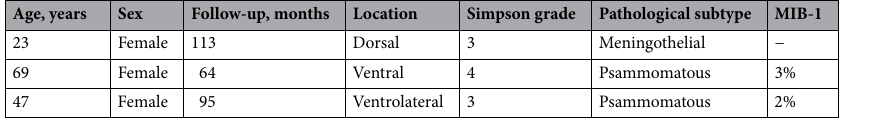
Table 3. Characteristics of patients with recurrence of meningioma. The median duration until recurrence was 95 months. MIB-1 index: Ki-67 scoring.